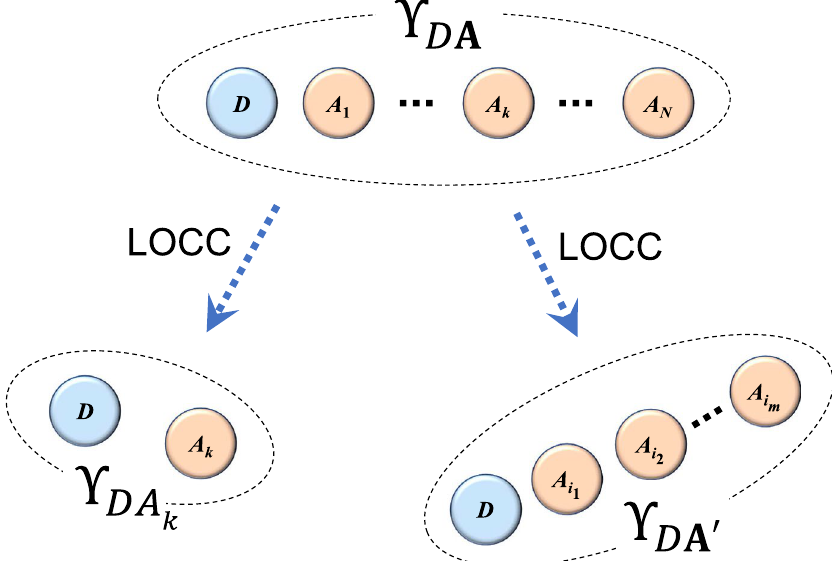
with smaller number of ′